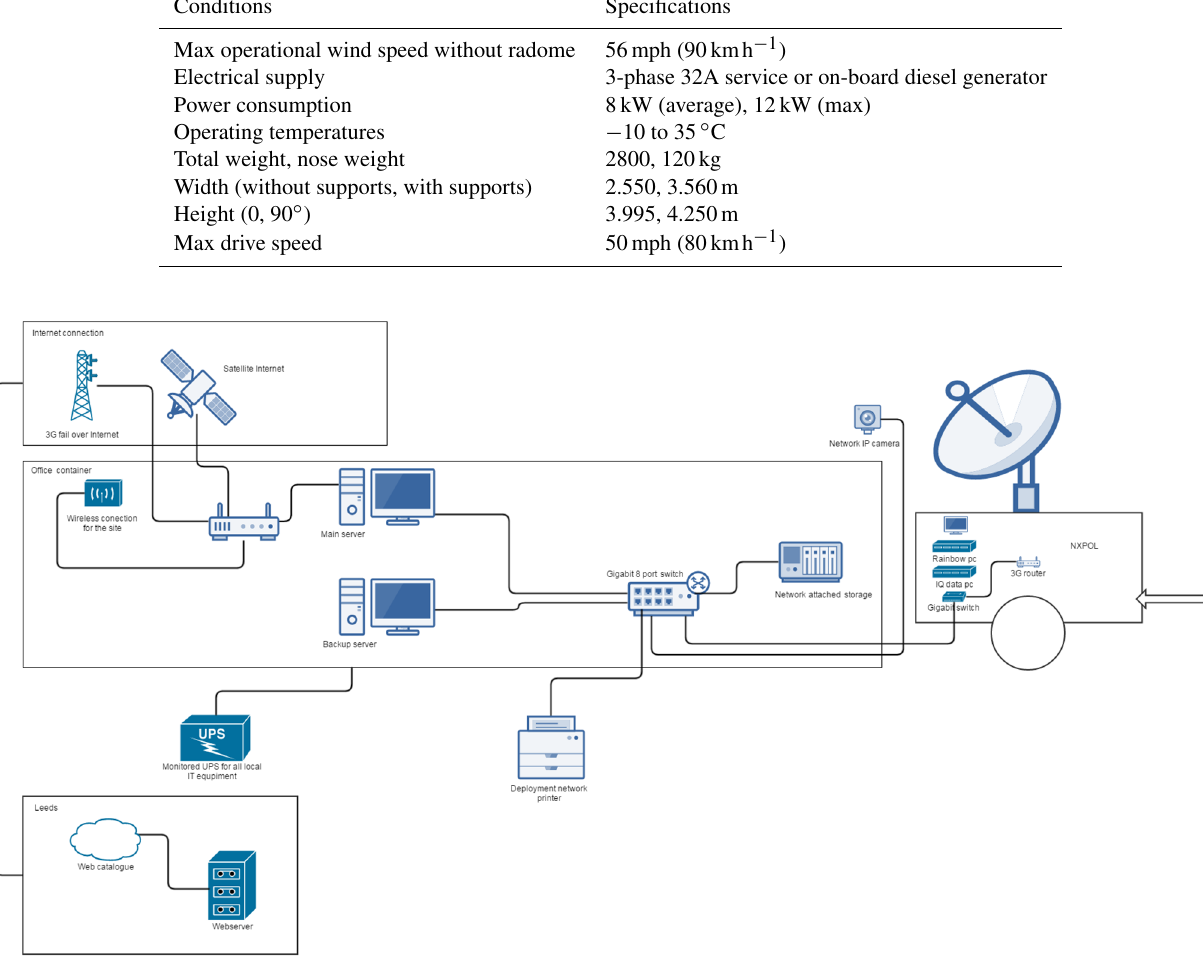
Figure 4. Schematic of the IT infrastructure used by the NXPol when on